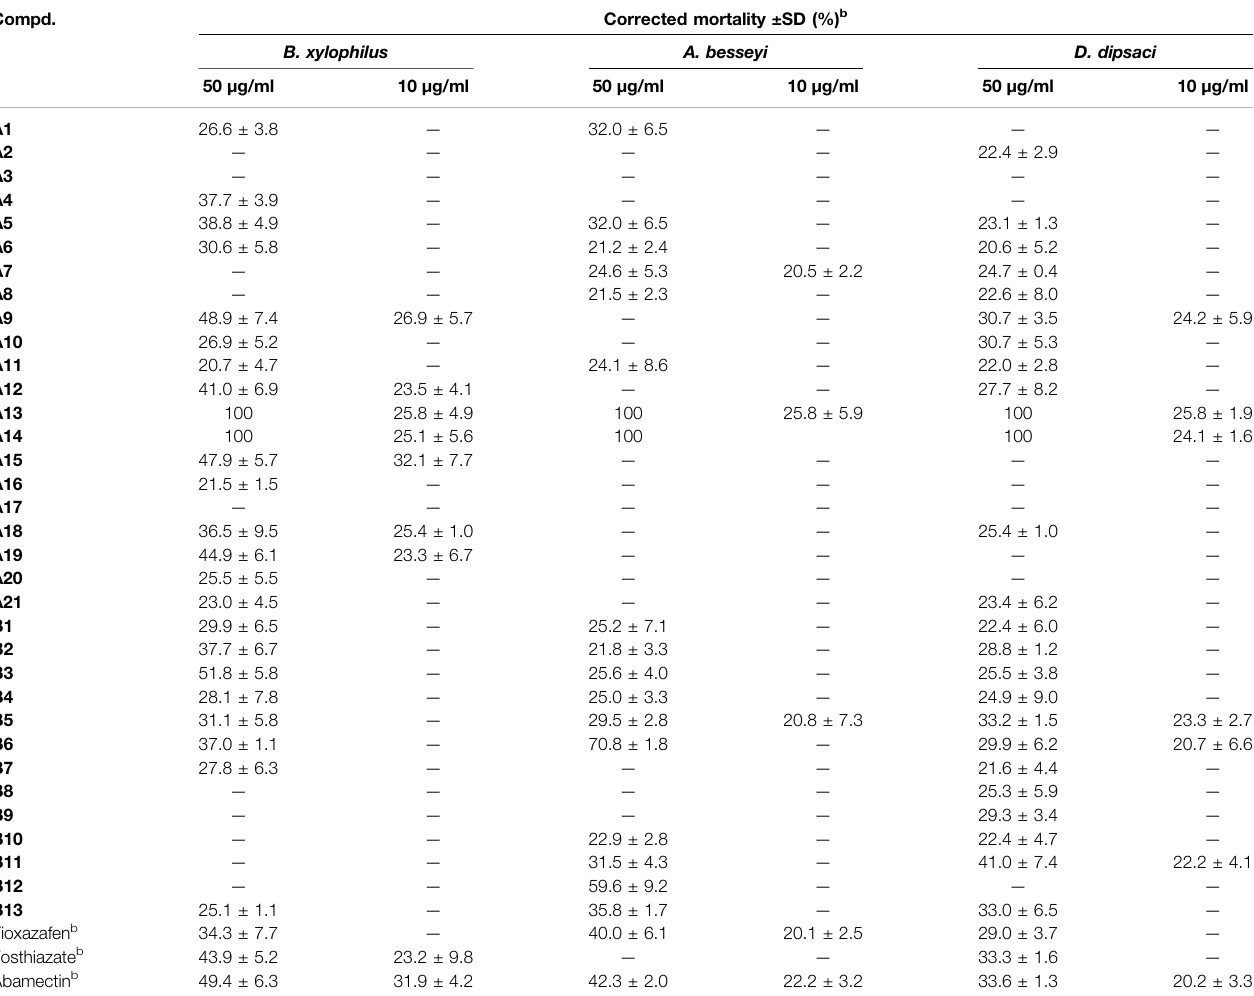
TABLE 2 | Nematicidal activity of compounds A1 − A21 and B1 − B13 . a